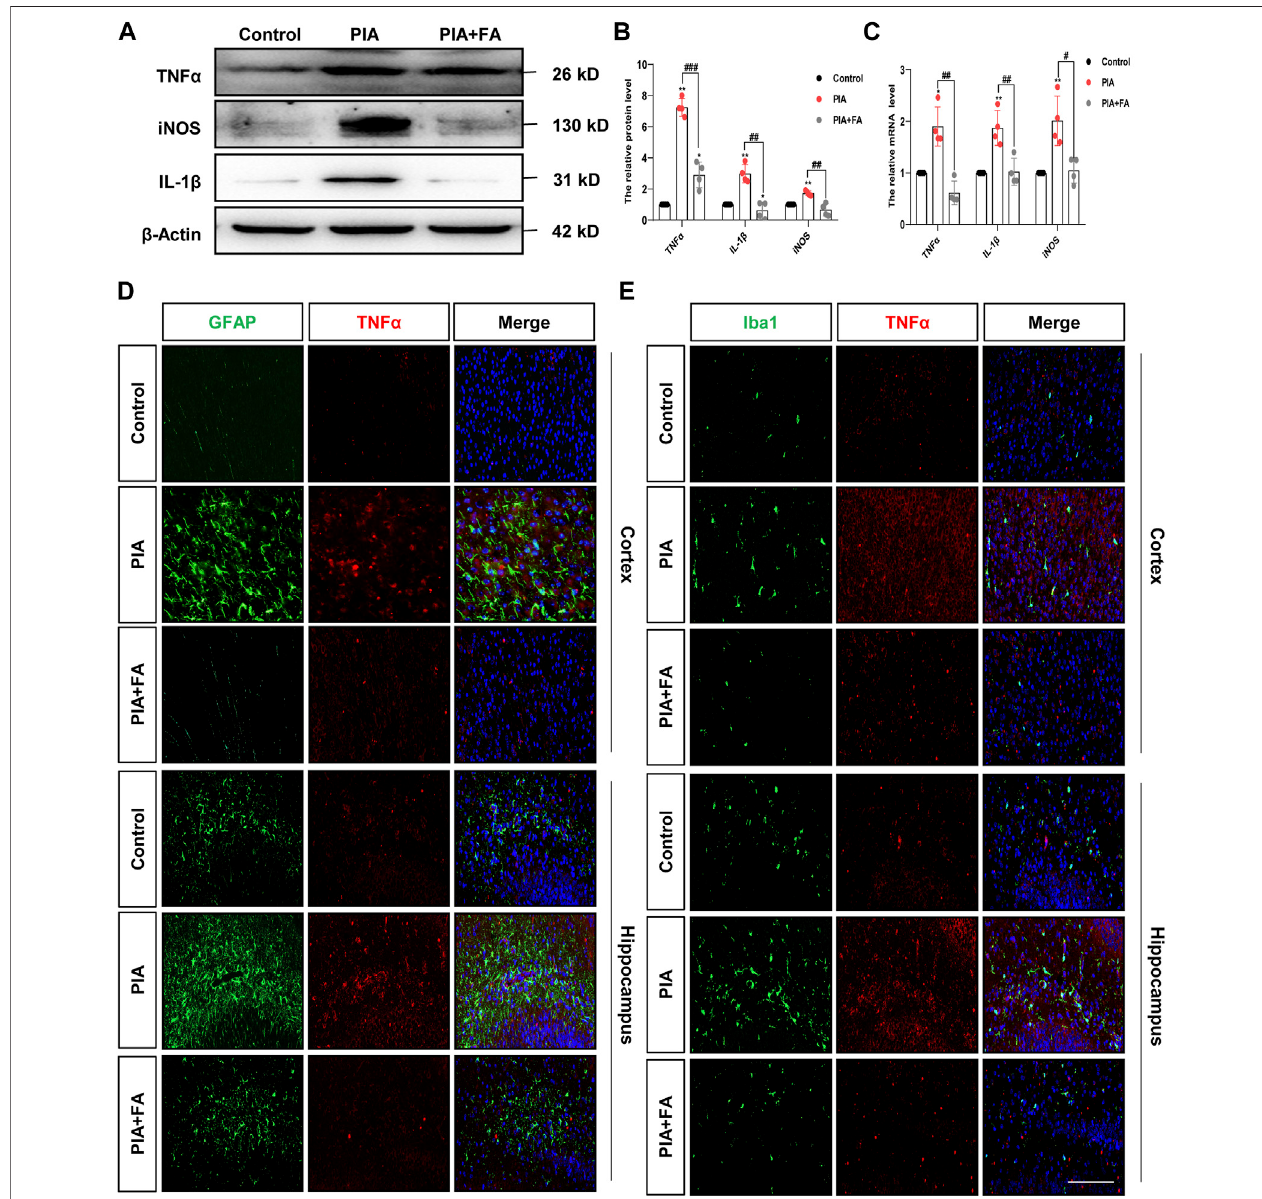
FIGURE 3 | FA reduced the expression of pro-in fl ammatory mediators in astrocytes and microglia in the PIA model. (A,B) Representative images and quanti fi cation of Western blotting analysis of pro-in fl ammatory mediator TNF α , iNOS, and IL-1 β protein level in the brain of neonatal mice. (C) Quanti fi cation of the mRNA levels of pro-in fl ammatory mediators in the brain of neonatal mice. (D) Cortex sections were stained for GFAP (green) and TNF α (red). Nuclei were stained with DAPI (blue). Increased TNF α and GFAP intensity by PIA induction was lowered with FA treatment. (E) Cortex sections were stained for Iba1 (green) as the microglia marker and TNF α (red). Nuclei were stained with DAPI (blue). Increased TNF α and Iba1 intensity by PIA induction was lowered with FA treatment (scale bar: 20 μ m). Data: mean ± SEM; * p < 0.05, ** p < 0.01 versus the control group; # p < 0.05, ## p < 0.01, ### p < 0.001 versus the PIA group; n = 4 per group (one-way